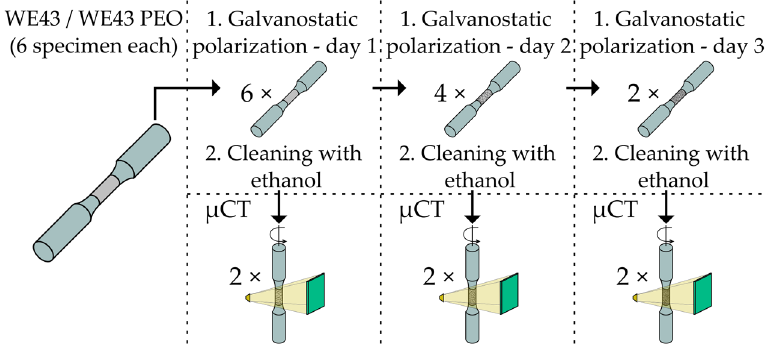
Figure 6. Experimental procedure and number of specimens for each time interval.